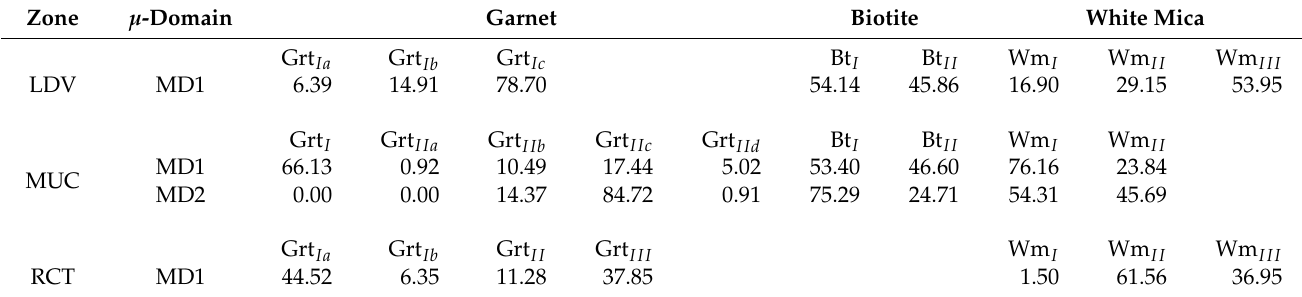
Table 7. Q-XRMA Second Cycle—Sub-Phases